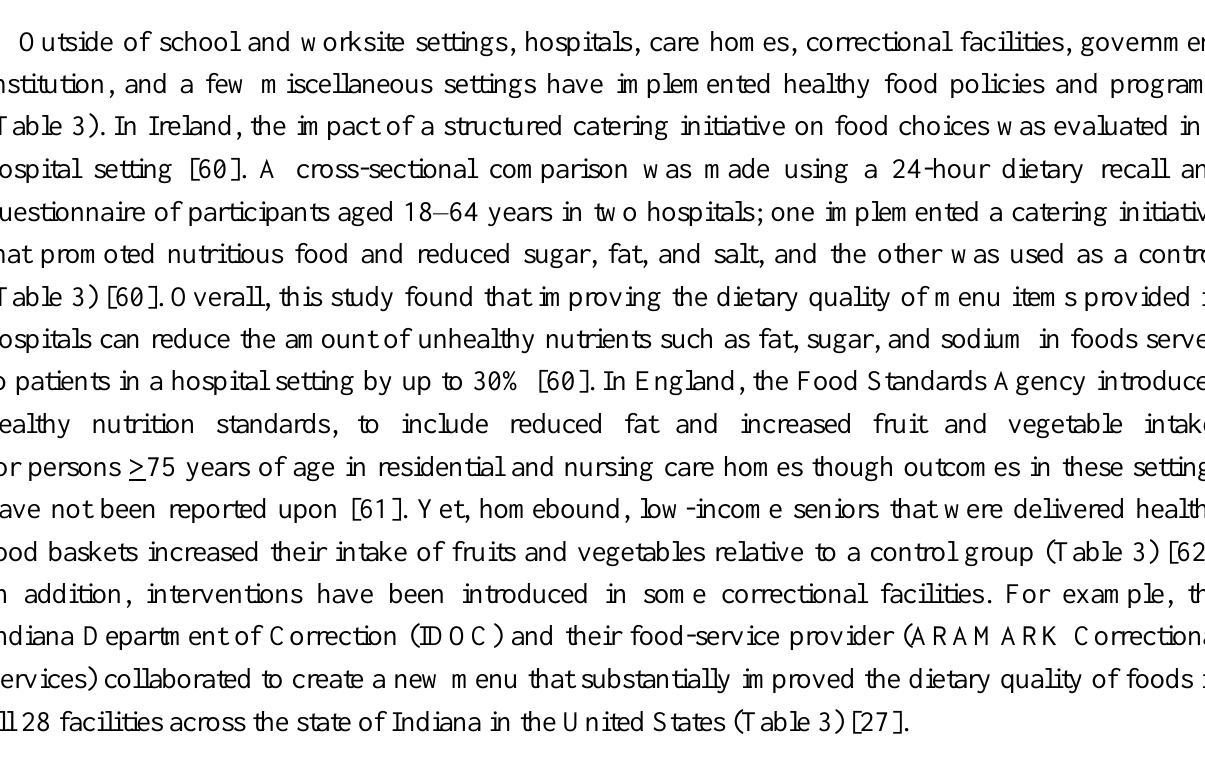
3. Healthy Food Procurement Programs in Hospitals, Care